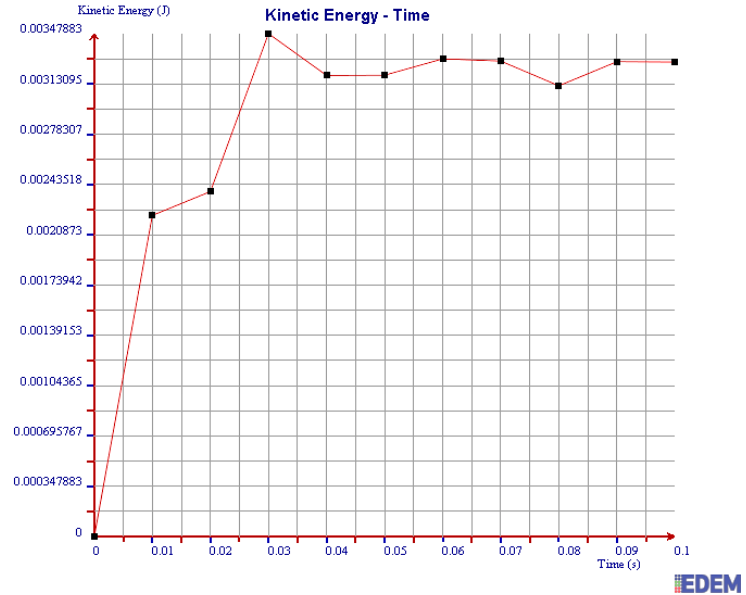
Figure. 18 Kinetic energy of 2 mm steel balls. Figure 18. Kinetic energy of 2 mm steel